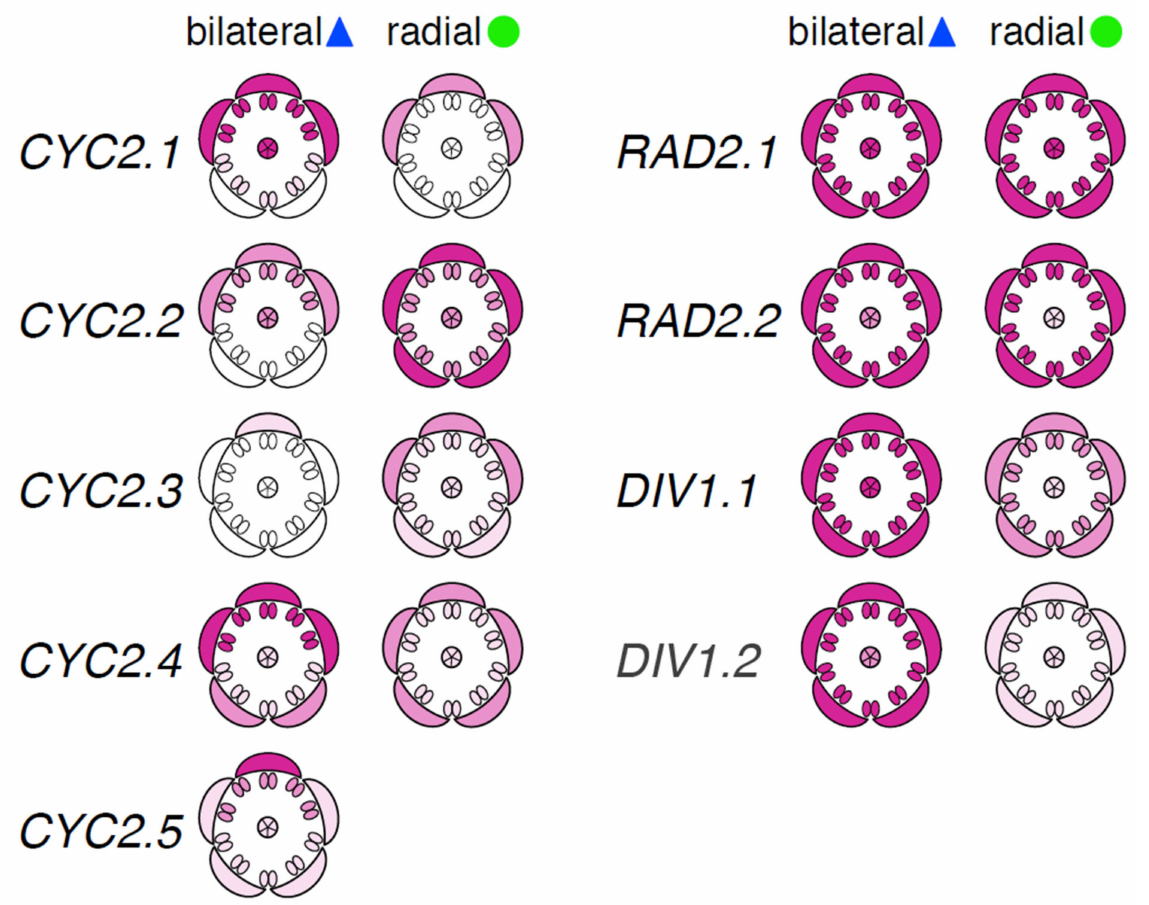
Figure 8. Summary of gene expression patterns for CYCLOIDEA ( CYC ), RADIALIS ( RAD ), and DIVARICATA ( DIV ) orthologs across floral organs in two Rhododendron species with different floral symmetries. Gene expression from RT-PCR was quantified and averaged across three biological replicates for each species, then visualized on floral diagrams of Rhododendron via cross-section. Floral diagrams show the five petals, ten stamens, and central pistil in flowers of the two species. Color intensity denotes expression level; white denotes no expression. Bilateral, blue triangle = bilaterally symmetric R. beyerinckianum ; radial, green circle = radially symmetric R. taxifolium . Note: A CYC2.5 ortholog could not be found in R. taxifolium